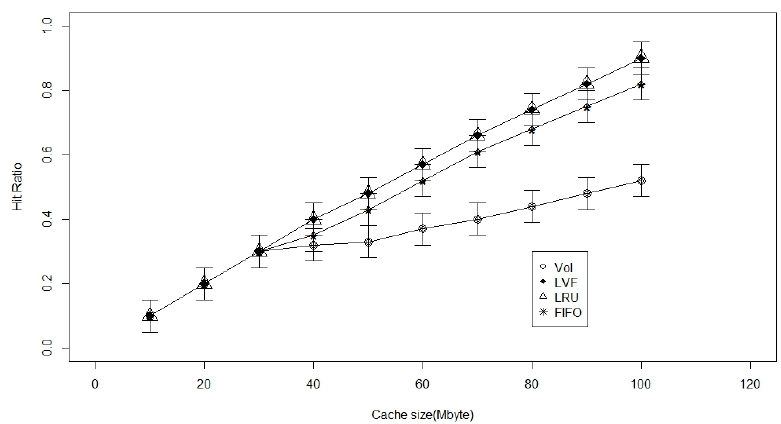
Figure 2. Cache size versus the hit ratio with 1-level caching.